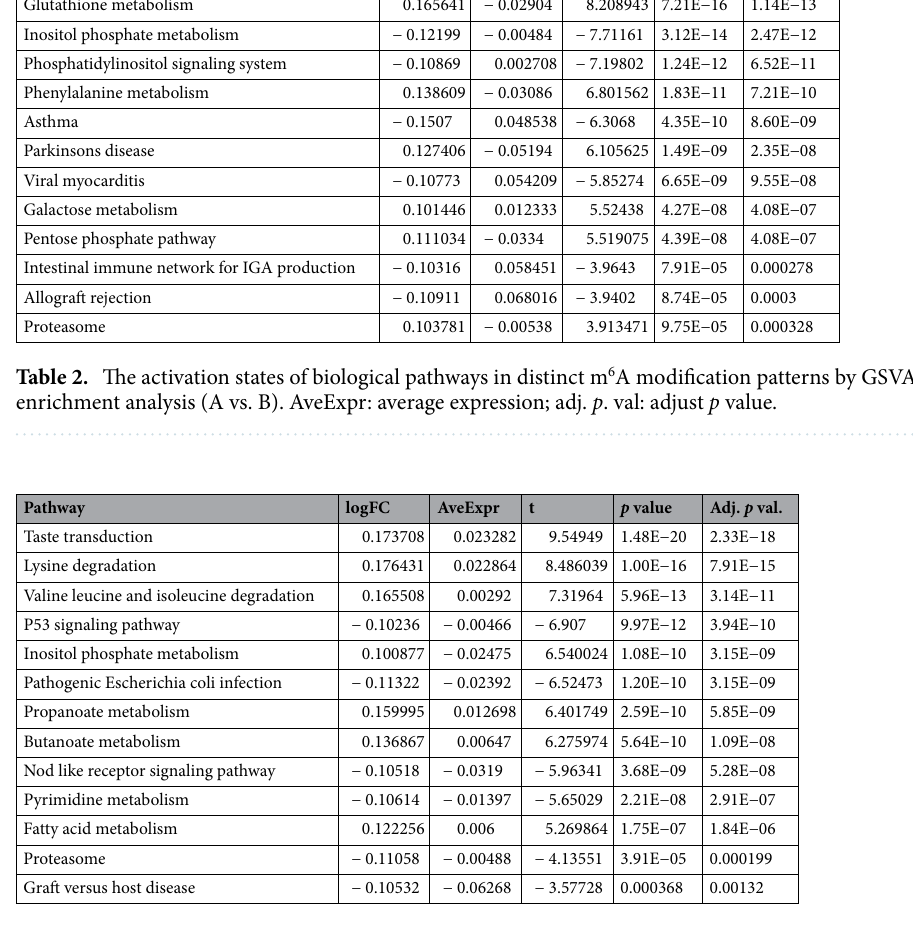
Table 3. The activation states of biological pathways in distinct m 6 A modification patterns by GSVA enrichment analysis (B vs. C). AveExpr: Average expression, adj.P.Val: adjust P